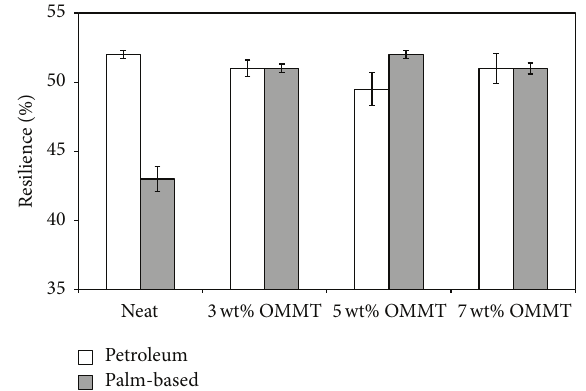
Figure 11: Resilience of PU nanocomposite foams and PU bio- nanocomposite foams with different amounts of